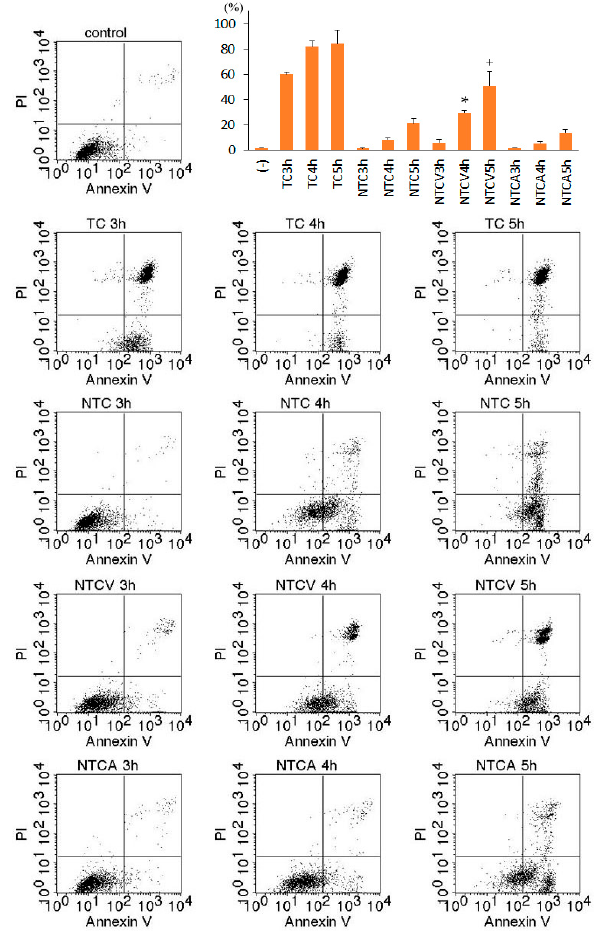
Figure 7. Induction of apoptosis in TNF-treated L929 cells in the presence of necrostatin-1 (dual staining with Annexin V and propidium iodide). L929 cells were treated with 10 μ M necrostatin-1 (N), 10 ng/mL TNF (T), 10 μ g/mL cycloheximide (C) with or without 10 μ M Z-VAD-fmk (V) or 100 μ M Z-Asp-CH 2 -DCB (A) for the indicated times. AnV + /PI − : early apoptosis or early necroptosis; AnV + /PI + : necrosis (late apoptosis or late necroptosis). The graph shows the average of three independent experiments for AnV + /PI + cells. * p < 0.05 compared to NTC4h; + p < 0.05 compared to NTC5h.